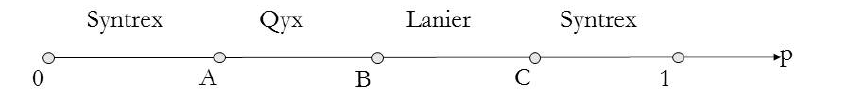
Figure 2. The second best choice by the difference method, where A = ( c 2 (cid:0) c 3 )/( b 2 (cid:0) b 3 + c 2 (cid:0) c 3 )